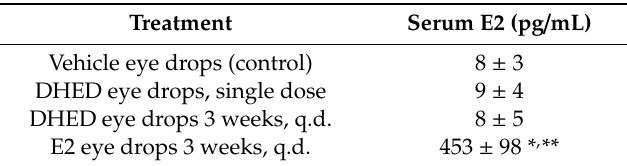
Table 2. Assessment of circulating E2 after three-week q.d. eye drop treatments (0.1% w / v DHED or E2 in 20% w / v HP β CD in saline solution) of OVX rats. Blood was collected 24 h after the last treatment. Blood E2 level 24 h after a single DHED eye drop is given as reference. Data are average ± SEM ( n = 6). * Significant di ff erence compared to control, p < 0.05, n = 6; ** Significant di ff erence compared to DHED treatments, p < 0.05, n = 6. Treatment Serum E2 (pg / mL) Vehicle eye drops (control) 8 ± 3 DHED eye drops, single dose 9 ± 4 DHED eye drops 3 weeks, q.d.